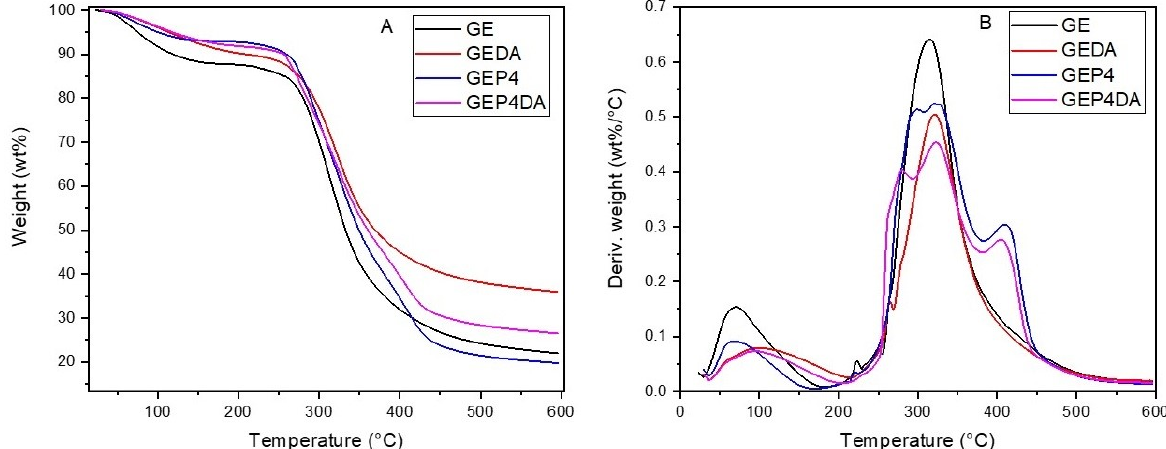
Figure 4. ( A ) Thermogravimetry (TG) curve of the films. ( B )-Derivative thermogravimetry (DTG) curves of the films.